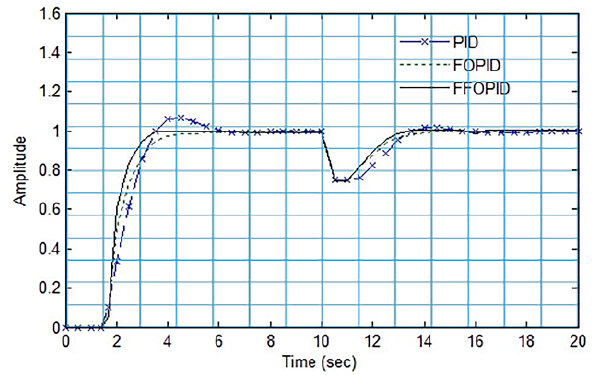
Figure 5. Step response of various controllers.